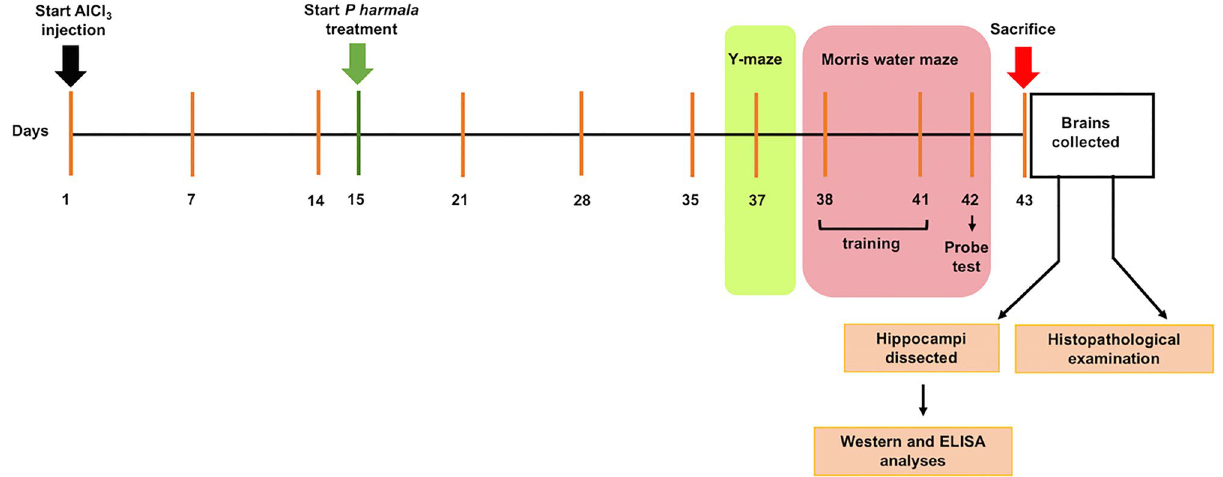
Figure 1. Schematic presentation of the experimental timeline. AlCl 3 was injected on day 1 and continued till day 42 and P. harmala administration started on day 15. Behavioral tests were commenced with Y-maze on day 37 followed by MWM with training sessions carried on days 38–41, probe test on day 42 and animal euthanasia on day 43. AlCl 3 aluminum chloride, MWM Morris Water Maze, P. harmala Peganum